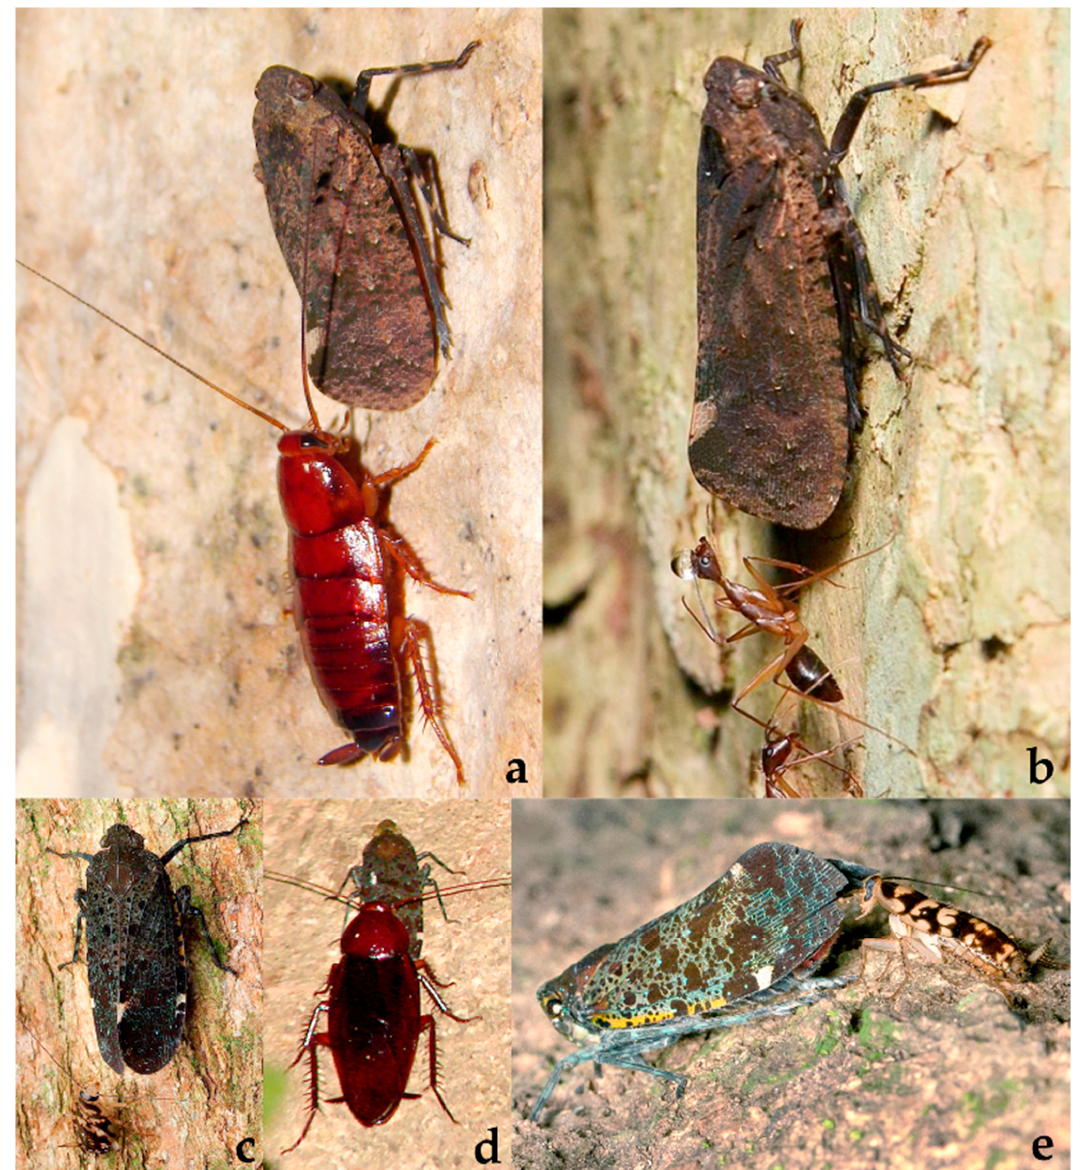
Figure 14. Fulgoridae: ( a ) Penthicodes pulchellus (Guérin-Méneville, 1838) tended by Blattodea indet., Vietnam: Phuoc Binh National Park, 12°00 ′ N 108°47 ′ E, 30.07.2014, adult on tree trunk, obs. J. Con- stant; ( b ) P. pulchellus tended by Formicidae indet., Thailand: Chiang Mai, Doi Suthep Pui, 18°49 ′ N 98°55 ′ E, 10.02.2015, adult on tree trunk, obs. W. Bunkhwamdi; ( c ) P. quadrimaculatus Lallemand, 1963 tended by Blattodea indet., Malaysia: Lambir Hills National Park, 4°11 ′ 38.7 ″ N 114°01 ′ 58.3 ″ E, 19.03.2008, adult on tree trunk, obs. C. Lee; ( d ) P. variegatus Guérin-Méneville, 1829 tended by Blat- todea indet., Vietnam: Nui Chua National park, 11°42 ′ N 109°09 ′ E, 8.08.2014, adult on tree trunk, obs. J. Constant; ( e ) P. variegatus tended by Blattodea indet., Thailand: Khao Sok National Park, 24.05.2019, obs. C. Hübner.